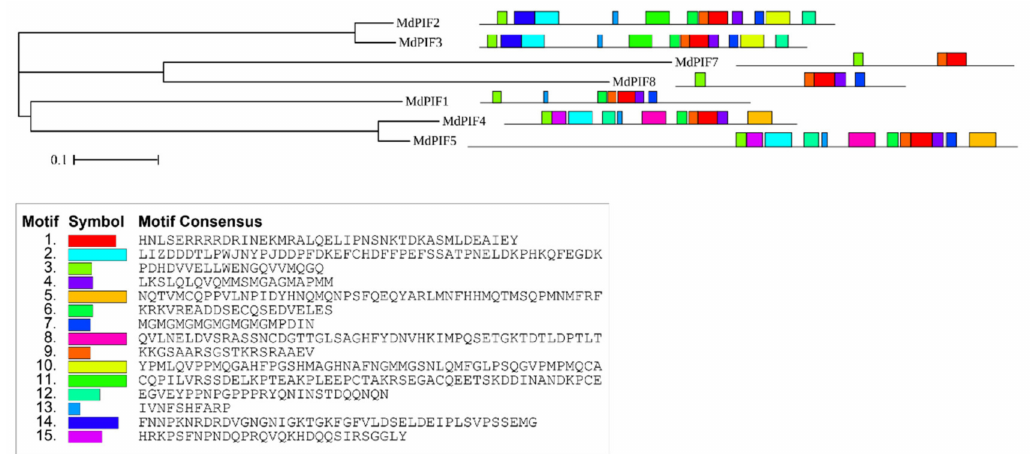
Figure 3. Schematic representation of the conserved motifs predicted in the MdPIF proteins. The MEME program was used to predict the conserved motifs, and TBtools was used to show the results.